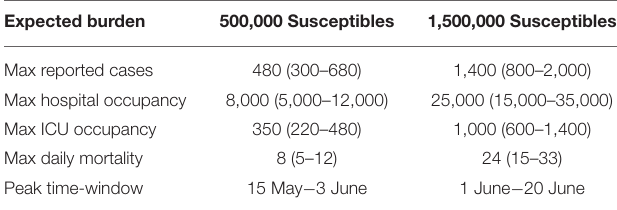
TABLE 2 | Projected epidemic and healthcare